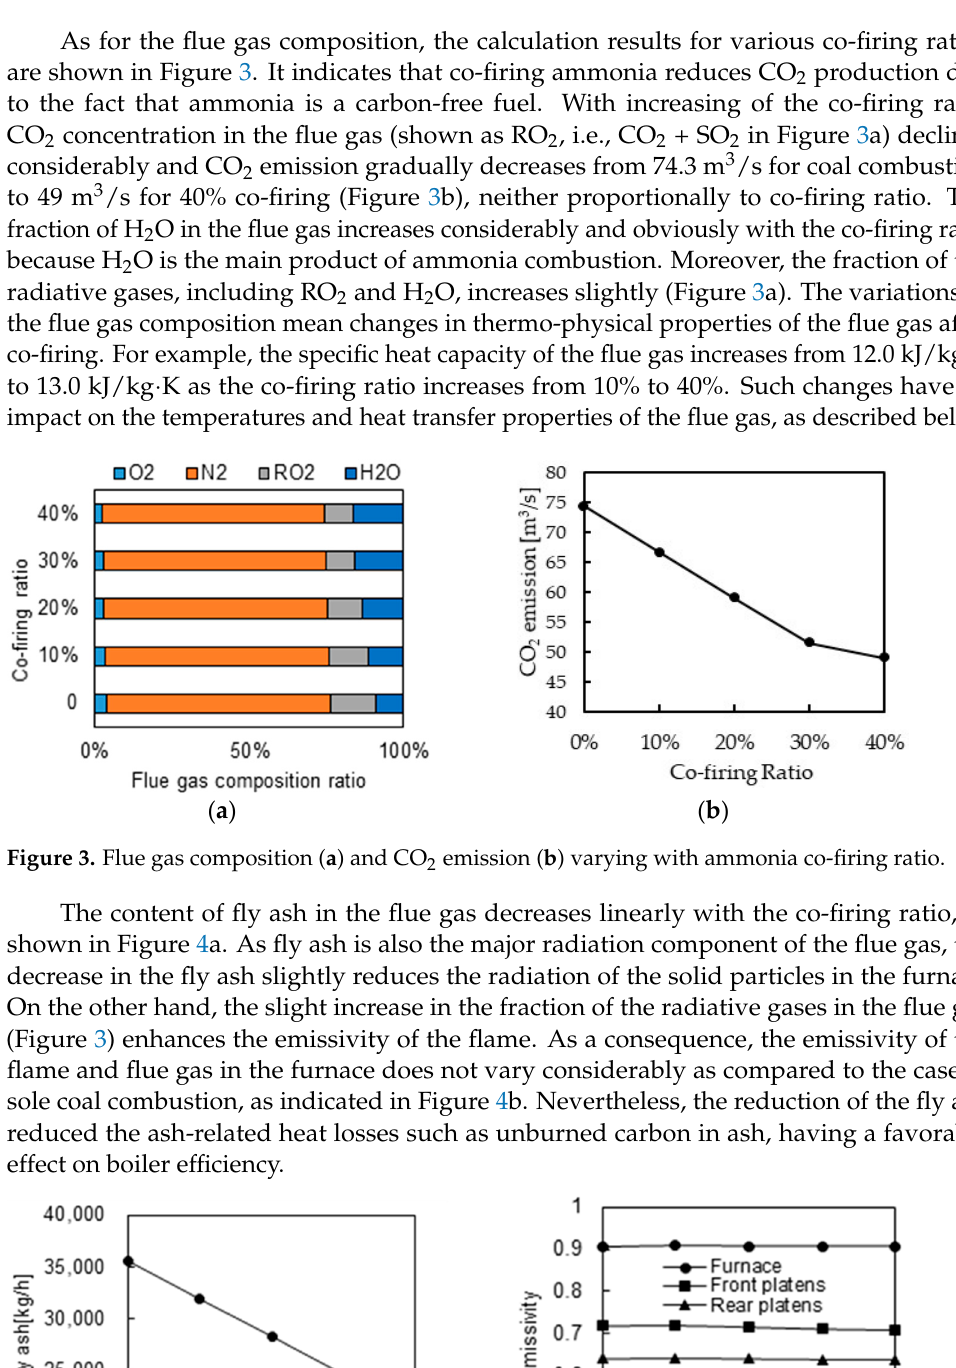
Figure 2. Volumetric flow rates of combustion air and flue gas.